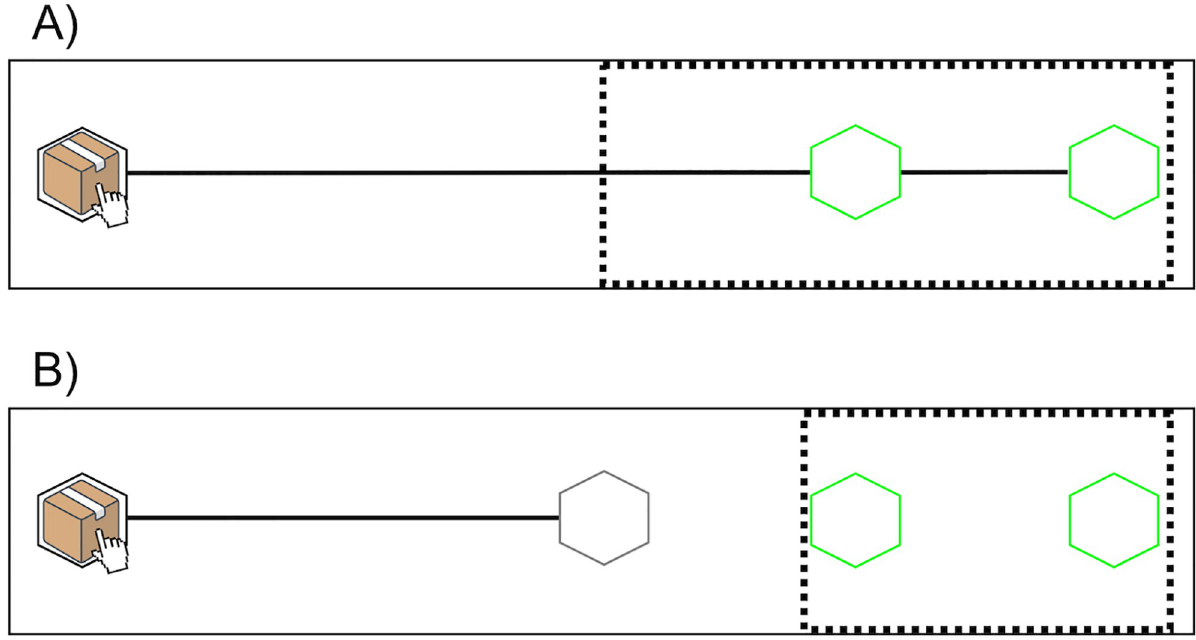
Fig 1. Experimental layout used in Experiments 1–3. Experimental layout in the (A) Proximal goal condition and the (B) Distal goal condition. The black dotted line represents the outline of the occluded area during trials, where the (near and far) target locations are displayed in light green.